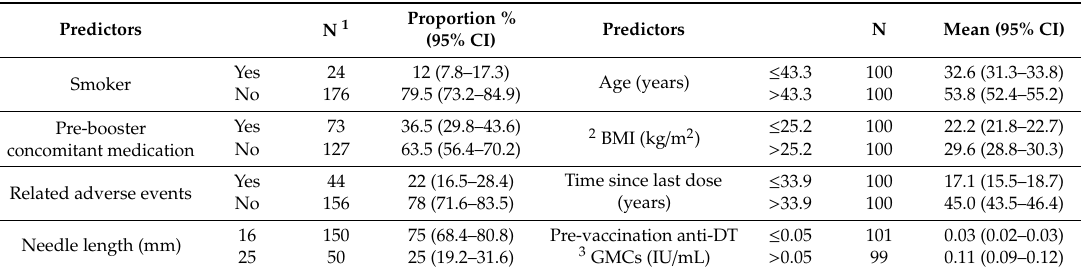
Table 1. Characteristics of the study population according to predictors expressed with proportions or means including the 95% confidence